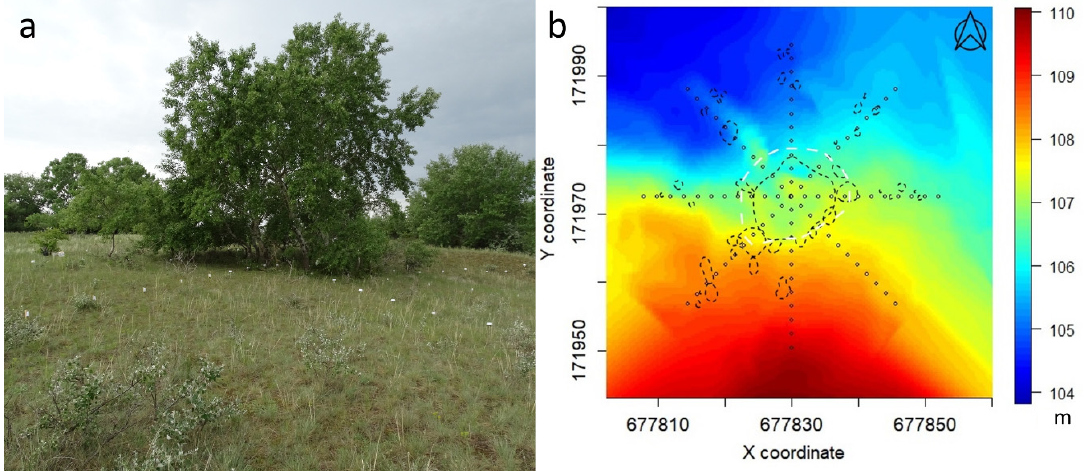
Figure 1. Study site ( a ) and relief map with the indication of the grove ( b ). Coordinates refer to the Hungarian Unified National Projection System. There were 89 measurement positions (4 × 22 positions in the four transects and the centre as position 12 in all transects). White dashed line: visual tree edge. Black dashed lines: the position and extent of individual shrubs and poplar sprouts.